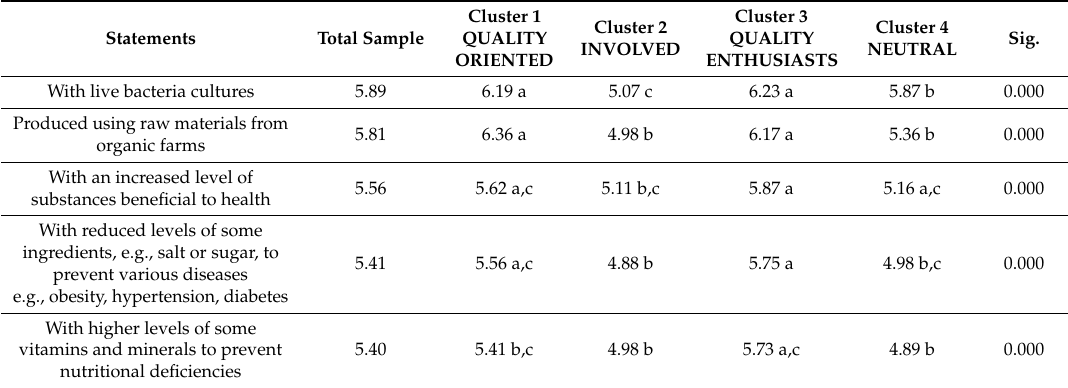
Table 6. Profile on attitudinal questionnaire referring to purchase of various yoghurt types ( N =